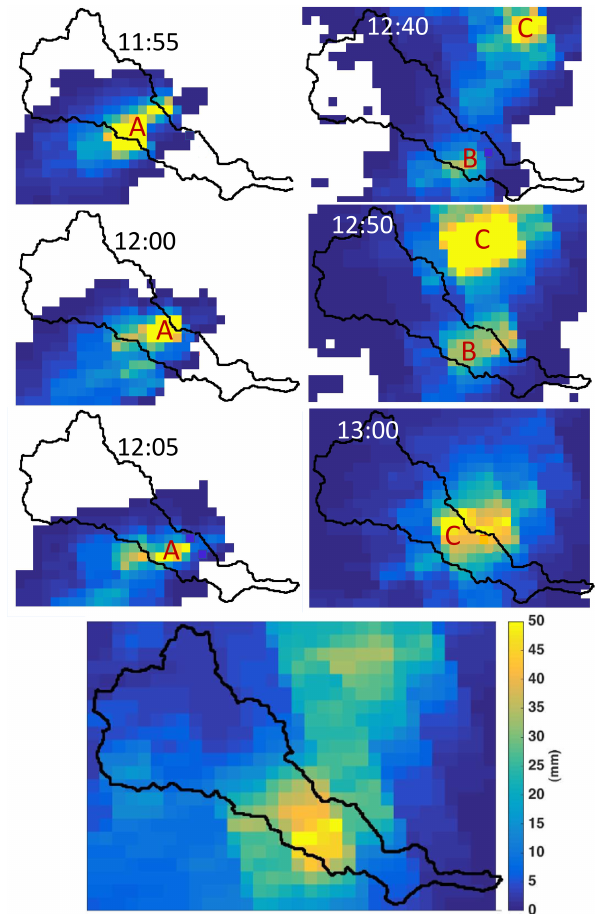
Figure 9. (a) . A series of radar images indicating the progres- sion of rain cells (denoted A, B and C) that crossed the Tzafit Basin (1 pixel is equivalent to 0.25km 2 ). The time notations refer to the summer clock (LST; UTC + 3h). The units are millimetres per hour (mmh − 1 ), based on the conversion method of Mara and Morin (2015). (b) Total rain amount accumulated between 11:40 and 13:40LST. Note the meridional orientation of the rainfall max- imum, pointing at the “training effect” (with the courtesy of Yair